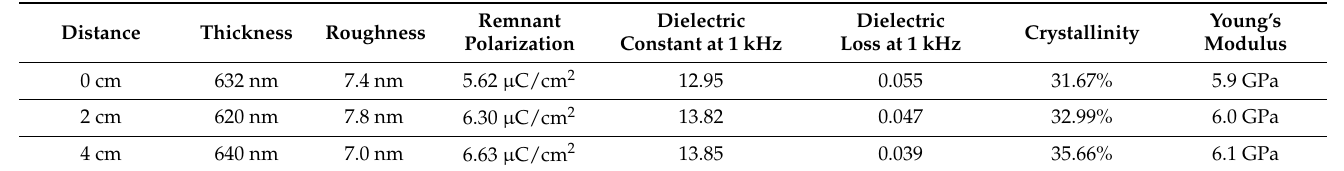
Table 1. Distance-dependent physical properties of P(VDF-TrFE) films during the spin coating. The rotational speed was fixed at 3000 rpm.